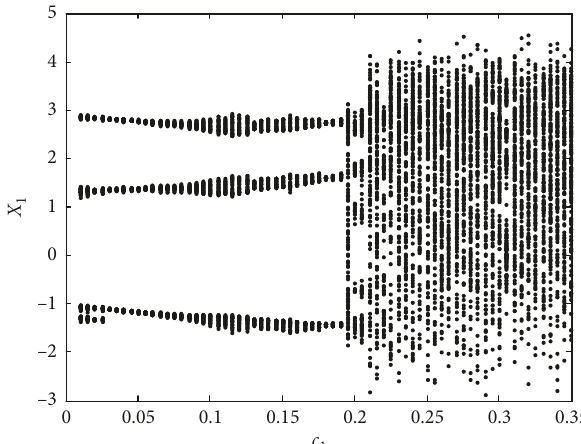
Figure 4: The displacement bifurcation graph of mean speed ( Ω � 2, ω � 1, c � 0.1, r � 0.5, p � 10, c 1 � 0.05, and the initial value is [0.01, 0, 0.01, 0]).